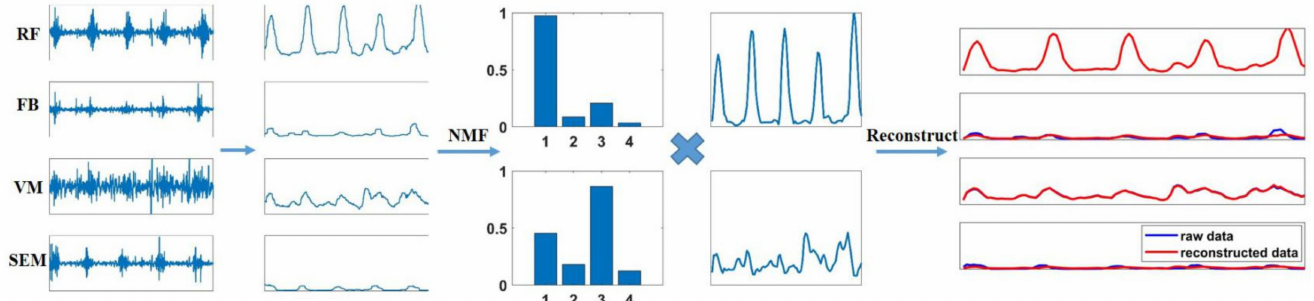
Figure 1. An example of the non-negative matrix factorization (NMF) decomposition of multiple channel surface elec- tromyography (sEMG) signals. The muscles are the rectus femoris (RF), femoral biceps (FB), vastus medialis (VM) and semitendinosus (SEM). The five subgraphs from left to right are raw sEMG signals, envelops of the sEMG signals, the muscle synergy pattern when k = 2, the activation coefficient when k = 2 and the comparison diagram between the original envelops and reconstructed